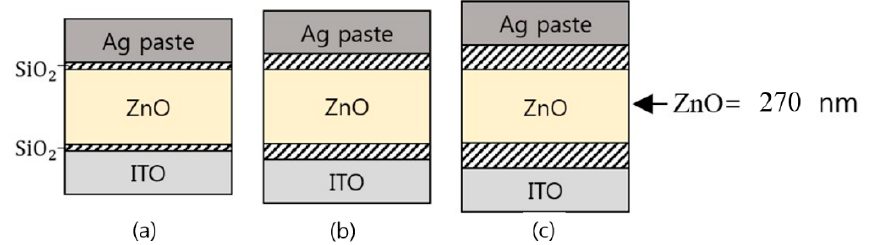
Figure 2. Schematic diagrams of three SiO 2 /ZnO/SiO 2 micro ‐ energy generators (SZS ‐ MGs) with different SiO 2 thin films. ( a ) Upper SiO 2 thickness = 78 nm, lower SiO 2 thickness = 40 nm; ( b ) upper SiO 2 thickness = 90 nm, lower SiO 2 thickness = 63 nm; ( c ) upper SiO 2 thickness = 146 nm, lower SiO 2 thickness = 110 nm. ITO: indium tin oxide.